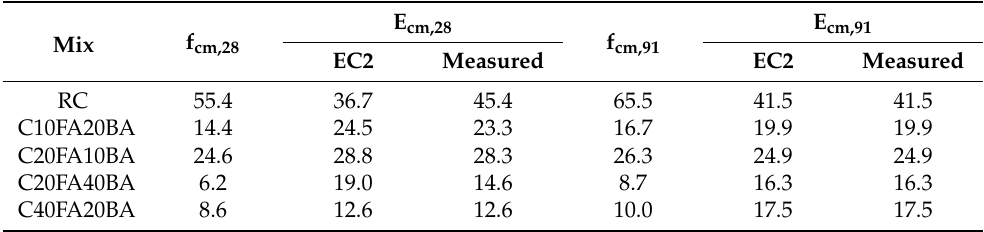
Table 6. Modulus of elasticity (E cm in GPa) versus compressive strength (f cm in MPa) according to EC2 at 28 and 91 days.